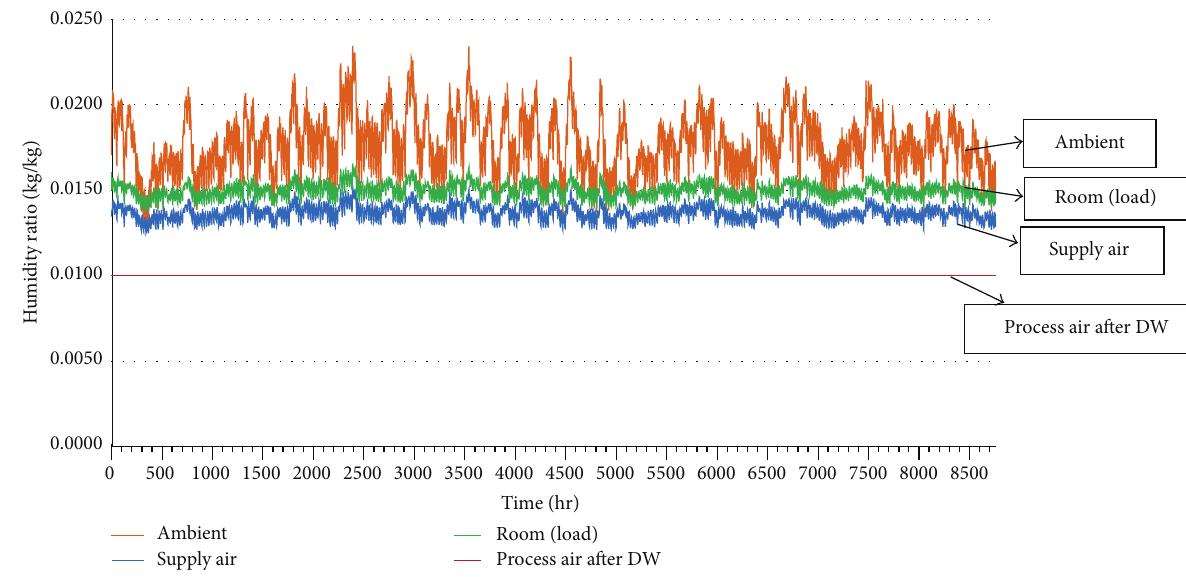
Figure 6: Humidity ratio (kg/kg) of different components versus time (hr) in ventilation desiccant cooling